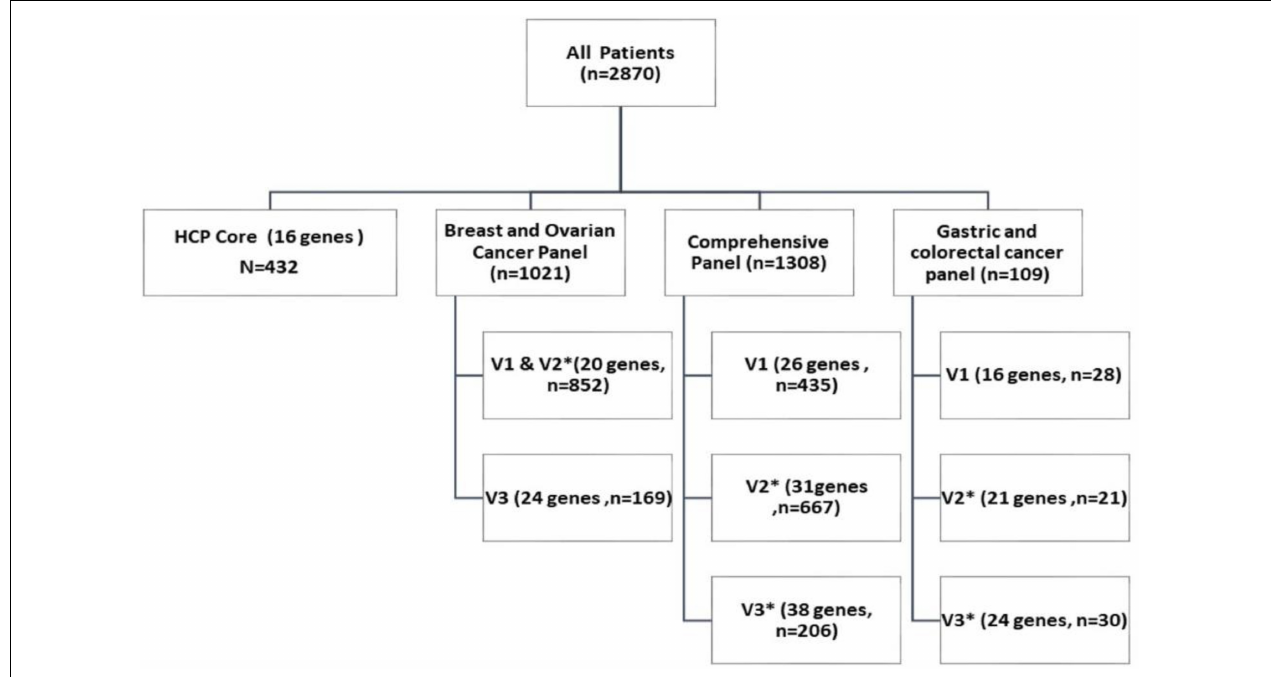
FIGURE 1 | Number of patients tested for hereditary cancer predisposition with multi gene targeted panel test: This chart describes number of patients tested with each sub-panel and versions. Each sub-panel and its respective version constitute of a set of genes associated with increased predisposition to specific cancers (List of genes included is described in Supplementary Table 2